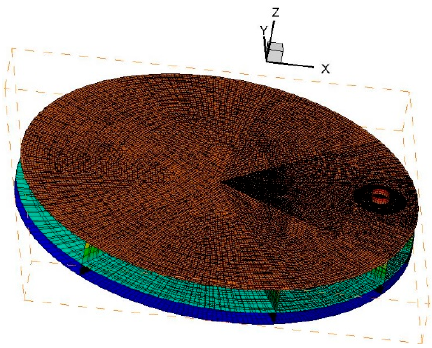
Figure 4. Mesh of the computational domain.